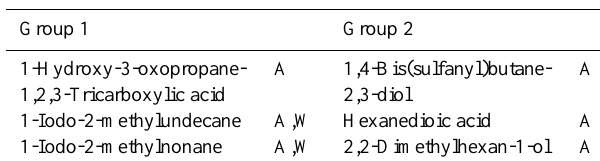
Table 2. Organic compounds found from filter as well as water and algal samples. Group 1 compounds were present in the filter sam- ples during the second event period, whereas Group 2 compounds were present during all event periods, but their absolute concentra- tion and contribution to the total organics was greatest during the second period. Compounds labelled with “A” have been found from algal and “W” from water